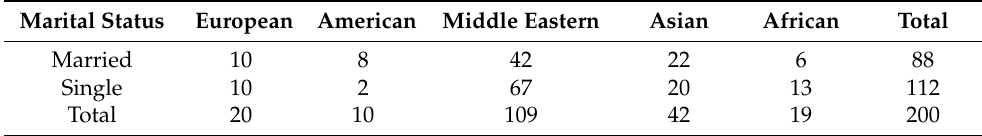
Table 1. Crosstab marital status vs. region of